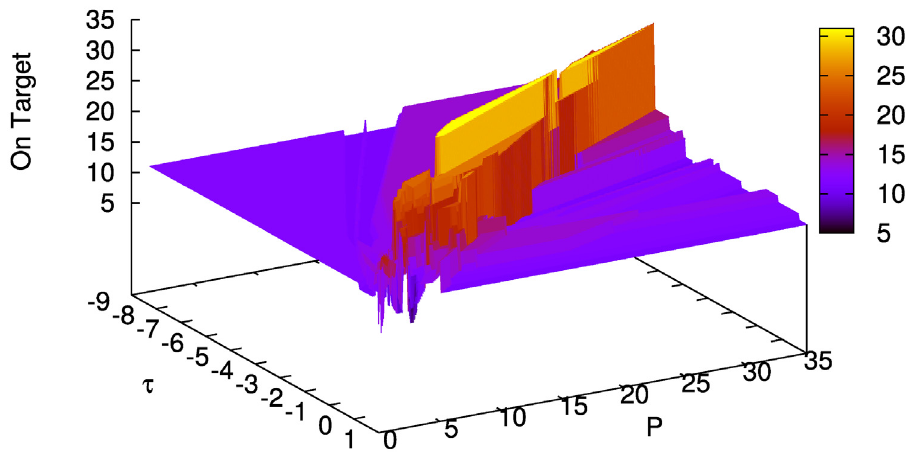
Fig 3. Rounds on target for input 0 (= u on 0 , u off 0 , u r 0 ) over 40 rounds on fi ne parameter grid with 66,086 grid points. With u on 2 f(cid:2) 1 ; ... ; 1 g , u off 2 f(cid:2) 2 ; ... ; 2 g , and u r 2 f(cid:2) 1 ; 0 ; 1 g 0 0 0